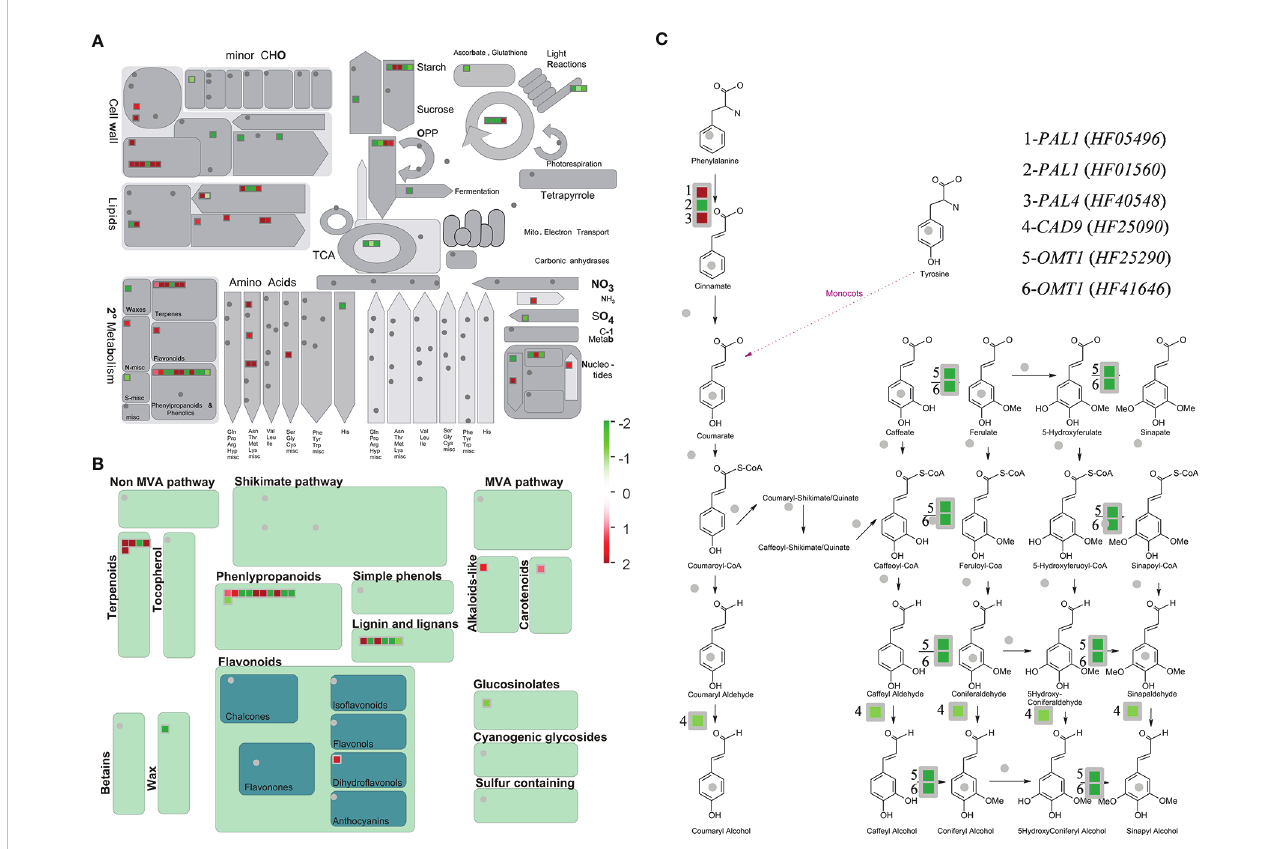
FIGURE 4 Metabolism overview and secondary metabolism of the identi fi ed DEGs associated with metabolic pathways for fl oral volatiles. (A, B) MapMan was used to classify the DEGs from the comparisons SF vs (WF and Mr). (C) Mapped DEGs involved in the phenylpropanoid pathway. Blue and red colors represent up- and down-regulated genes, respectively. Values represent the fold difference in expression level. Each square represents a DEG. Bins (or sub-bins) are shown as a block, which represent different metabolic